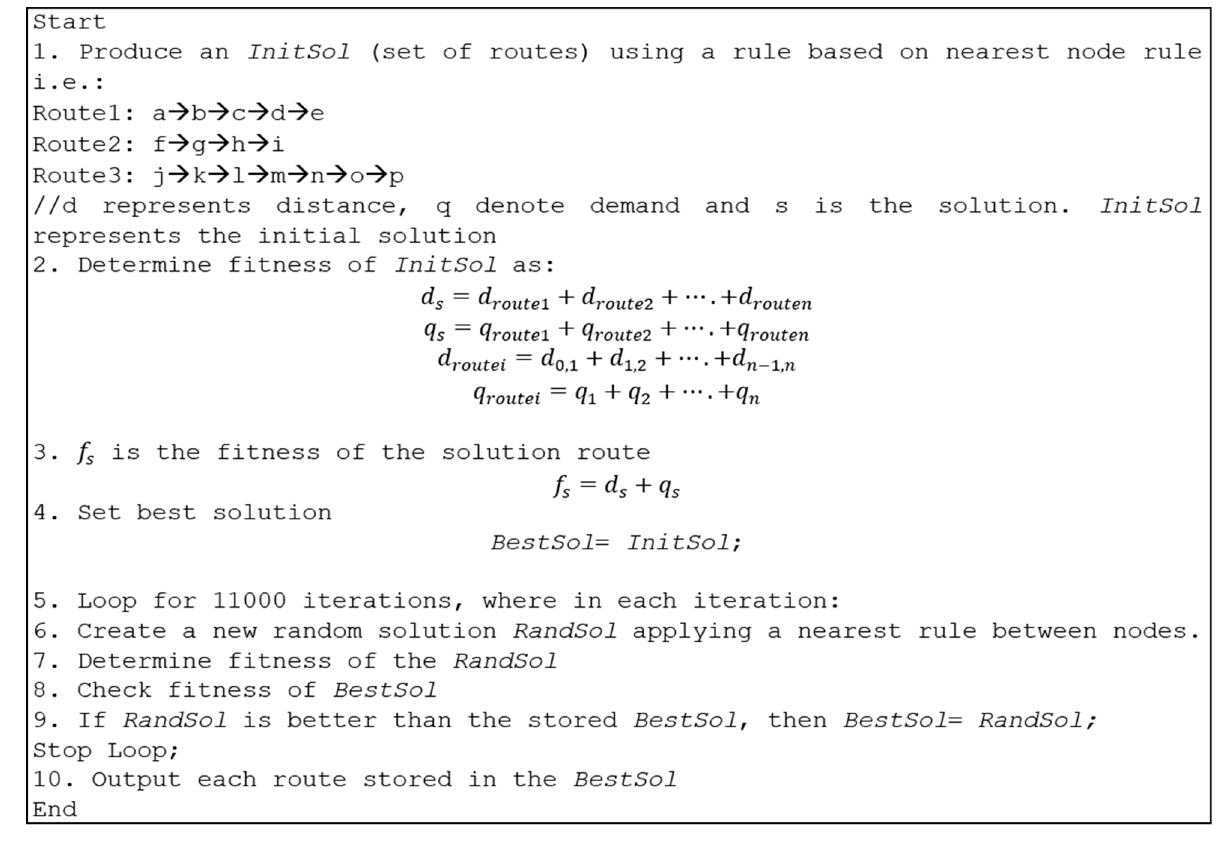
Figure 7. The pseudocode for the proposed tabu algorithm.